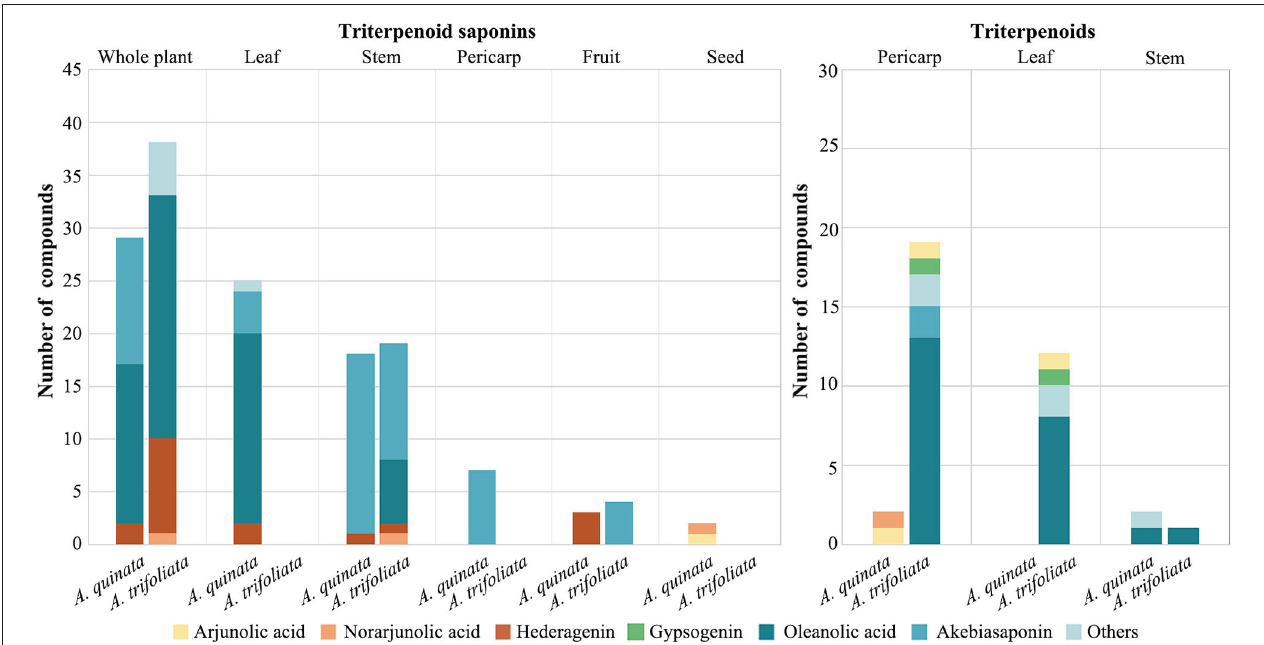
FIGURE 2 | Species and distribution of triterpenoid saponins and triterpenoid in Akebia plants. The statistics are based on a phytochemical review of the Akebia genus (Maciag et al.,